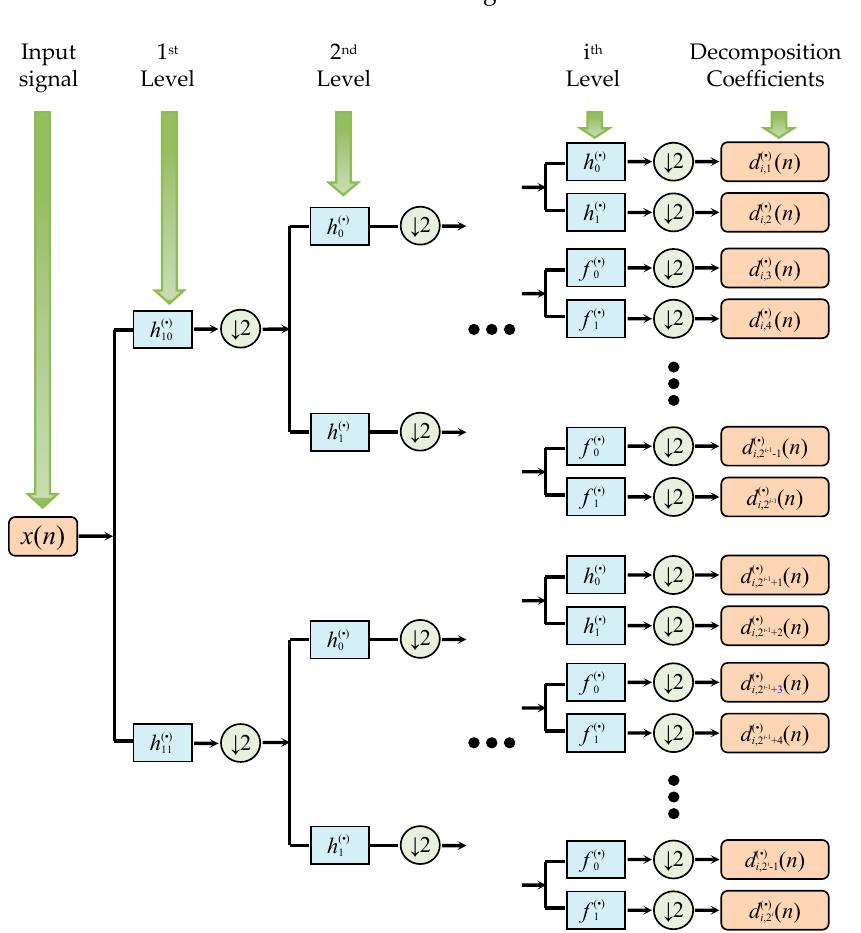
Figure 1. Filter-bank structure of the dual tree wavelet packet decomposition.